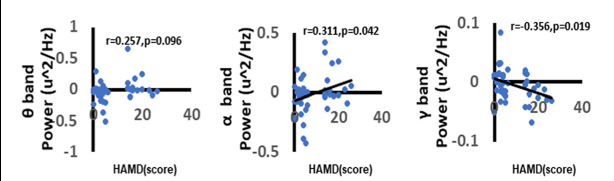
FIGURE 9 | Correlation between depression and neural oscillations. As shown in figure, there was a significant positive correlation between depression and α oscillations. Besides, we can also find that there was a significant negative correlation between depression and γ oscillations. While there no significant correlation between depression and θ oscillations. Only the significant correlation would show a trend line.